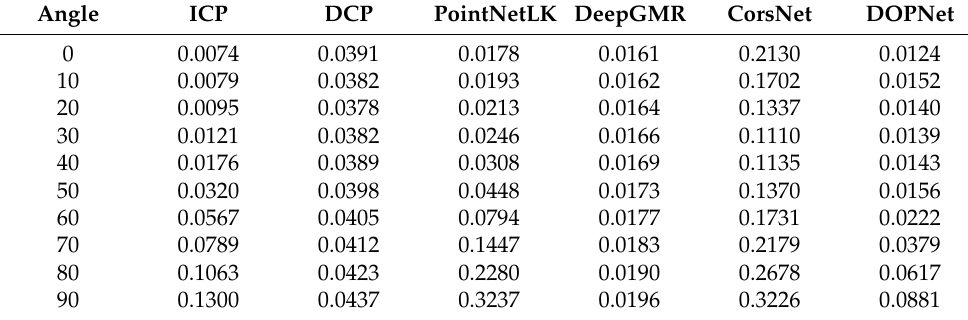
Table 4. Results of